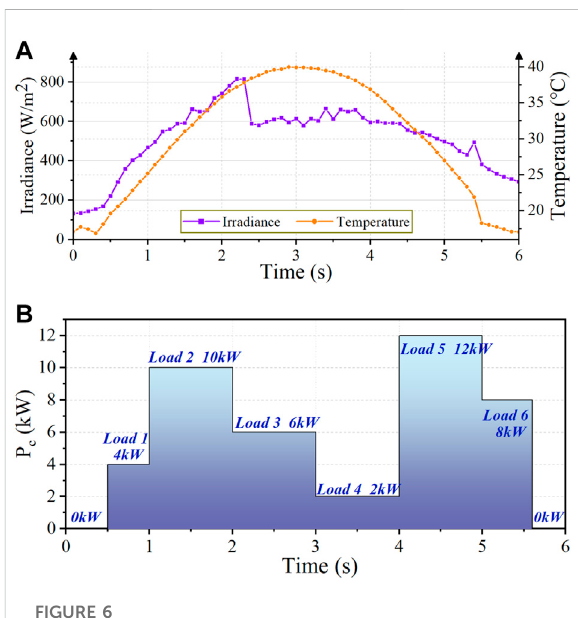
FIGURE 6 Variation of input and output conditions of the studied DC microgrid system. (A) Variation of solar irradiance and ambient temperature. (B) Variation of